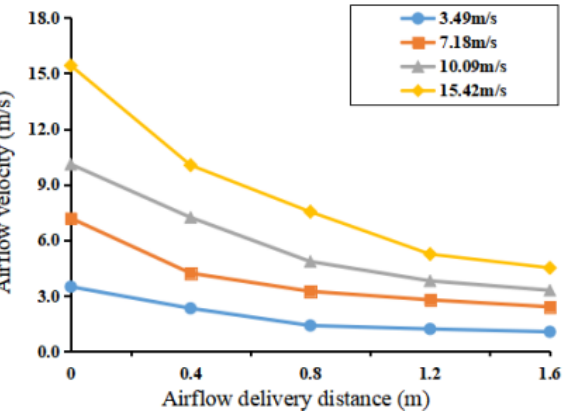
Figure 11. Variation in the airflow velocity under different fan frequencies and airflow delivery distances.